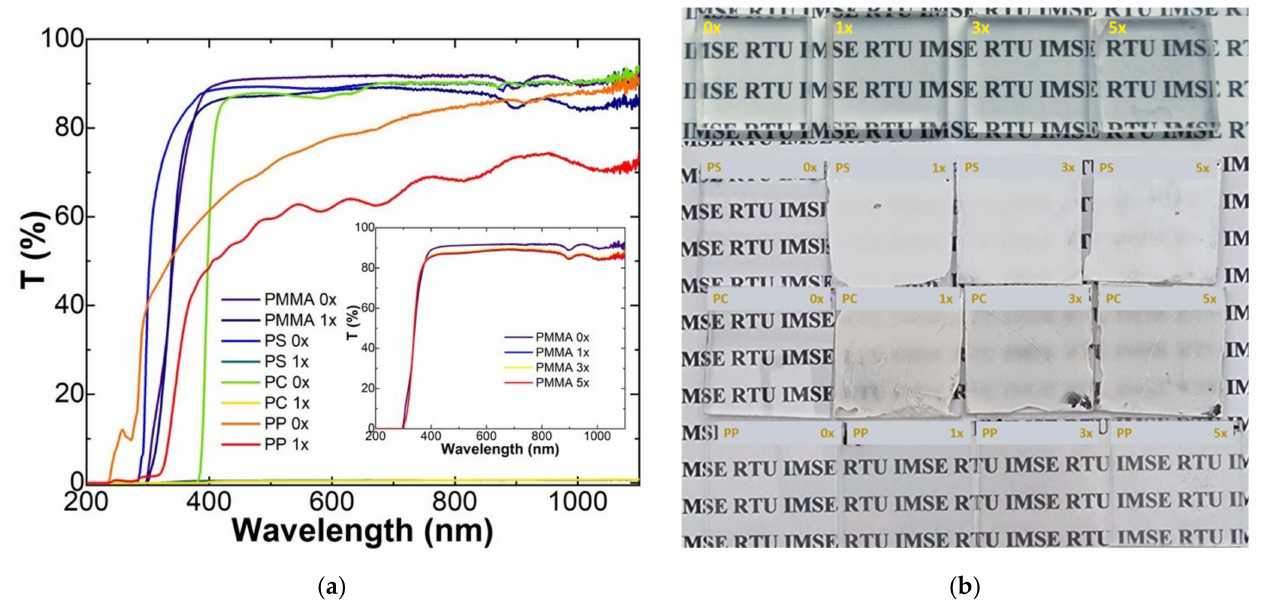
Figure 3. Optical properties of the produced samples. ( a ) Light transmittance changes before (0 × ) and after (1–5 × ) deposition of the TiO 2 coating; ( b ) produced sample photography showing their